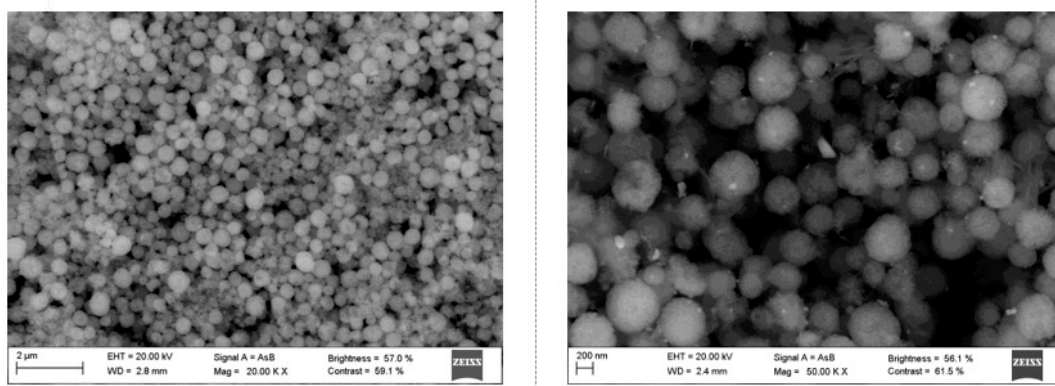
Figure 3. Scanning electron micrograph of the spherical ZnO aggregates ( left ); Detailed scanning electron micrograph of the ZnO–Ag nanocomposites, showing the presence of small Ag nanoparticles as brighter spots ( right ).